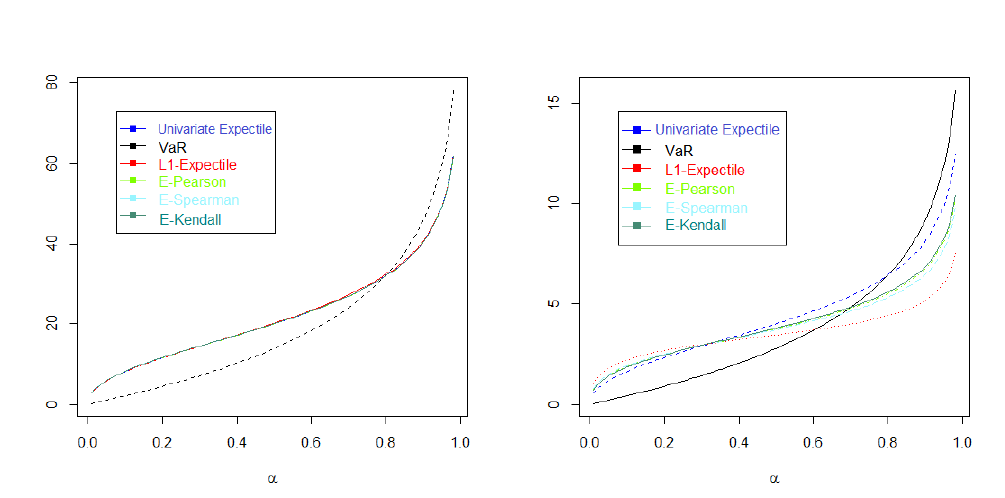
Figure 2: Impact of construction’s choice in FGM bivariate model with dependence parameter θ = 1 (left X 1 ∼ E (0.05) , right X 2 ∼ E (0.25) ).